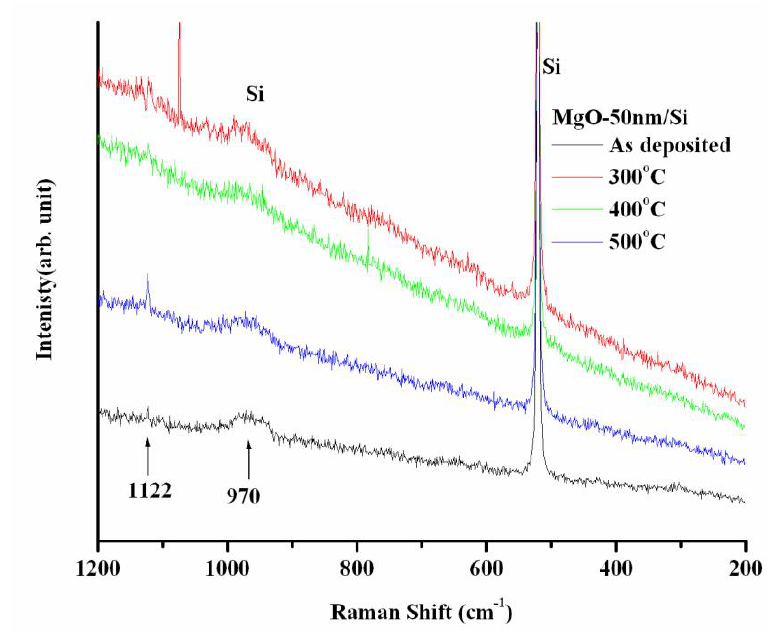
Figure 4. Raman spectra of as deposited MgO films of thickness 50 nm at 300, 400 and 500 o